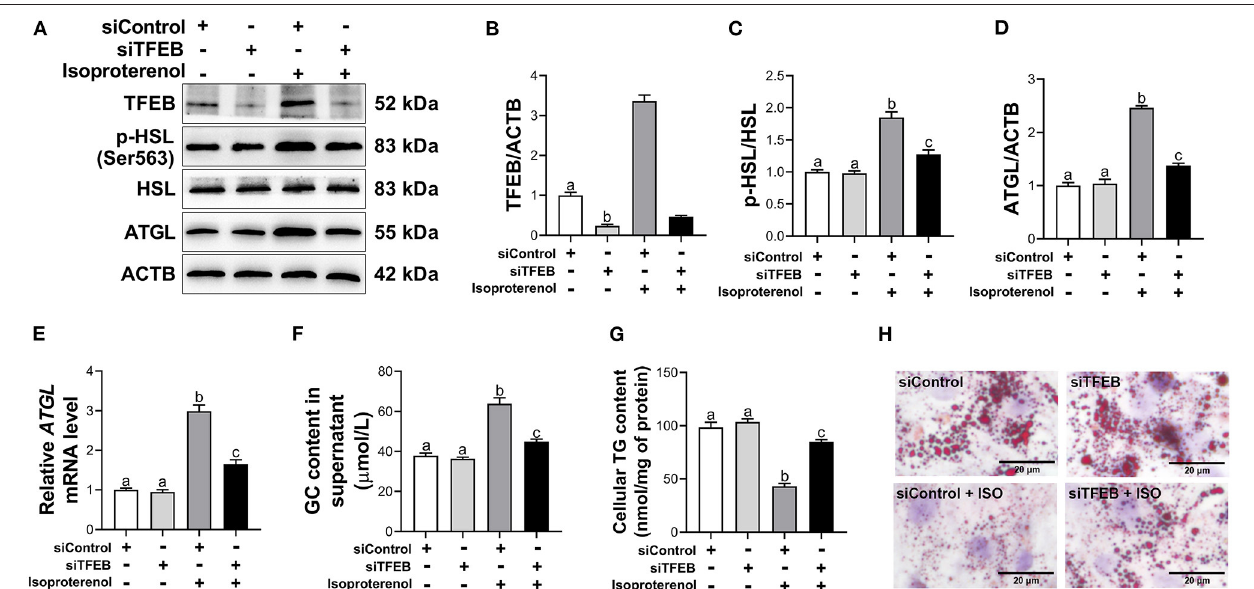
FIGURE 4 | Knockdown of transcription factor EB ( TFEB ) reduces isoproterenol (ISO)-induced lipolysis in calf adipocytes. The cells were divided into 4 groups as followed: an siControl group [transfected with negative control of small interfering RNA (siRNA) for 48h], and an siTFEB group (transfected with siRNA for TFEB for 48h), an siControl + ISO group (transfected with negative control of siRNA for 48h and then treated with 10 µ M ISO for 3h), and an siTFEB + ISO group (transfected with siRNA for TFEB for 48h and then treated with 10 µ M ISO for 3h). (A) Western blot analysis of TFEB, phosphorylated hormone sensitive lipase (p-HSL), HSL and adipose triacylglycerol lipase (ATGL) in bovine adipocytes. Representative blots are shown. (B–D) Quantification of protein abundance of TFEB, ratio of p-HSL/HSL and protein abundance of ATGL, respectively. (E) Relative mRNA abundance of ATGL in calf adipocytes. (F) The content of glycerol (GC) in the supernatant of calf adipocytes. (G) The triglyceride (TG) content in calf adipocytes. (H) Oil Red O staining. Scale bar = 20 µ m. Data were analyzed using one-way or two-way ANOVA with Tukey’s tests for data meeting homogeneity of variance or with Tamhane’s T2 analysis for data of heteroscedasticity and expressed as mean ± SEM. The same letter (a-c) indicates no significant difference ( P > 0.05), whereas different letters indicate a significant difference ( P <